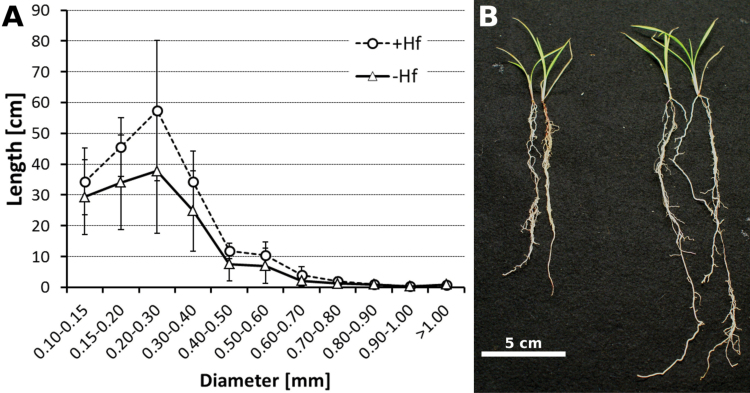
Root morphology and fine root structural changes of M. sinensis following inoculation with H. frisingense. (A) Root length of different diameter classes without inoculation (triangles) and with inoculation (circles). Quantitative root parameters were deduced using a WinRHIZO system. (B) Seedling appearance without inoculation (left) and with inoculation (right). Note the increased root system. (This figure is available in colour at JXB online.)